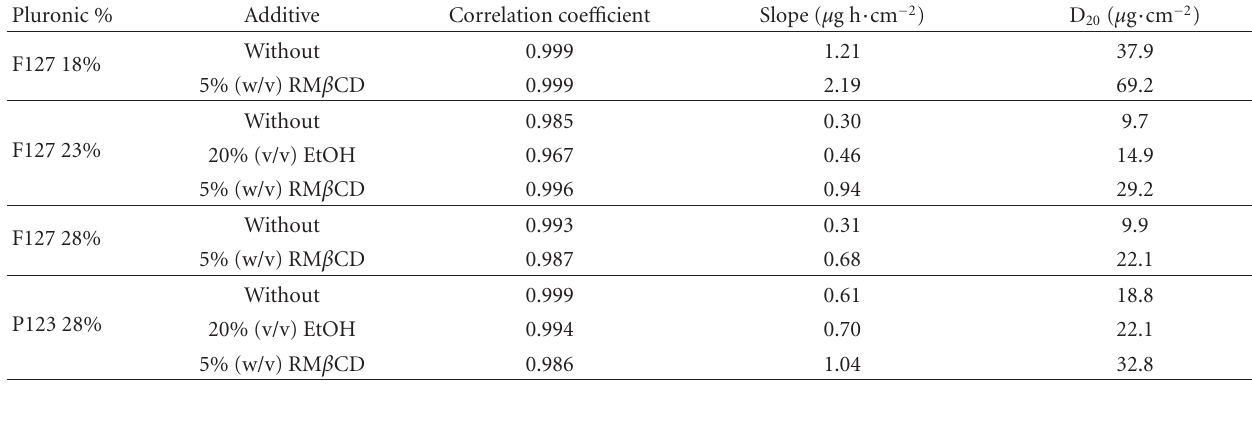
Table 4: Data from fitting β LAP release profiles to zero-order kinetics and total amount of drug released at the end of the assay (D 20 ).